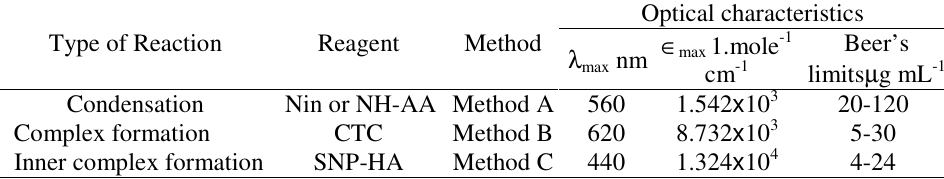
Table 1 . List of proposed and reported visible spectrophotometric methods